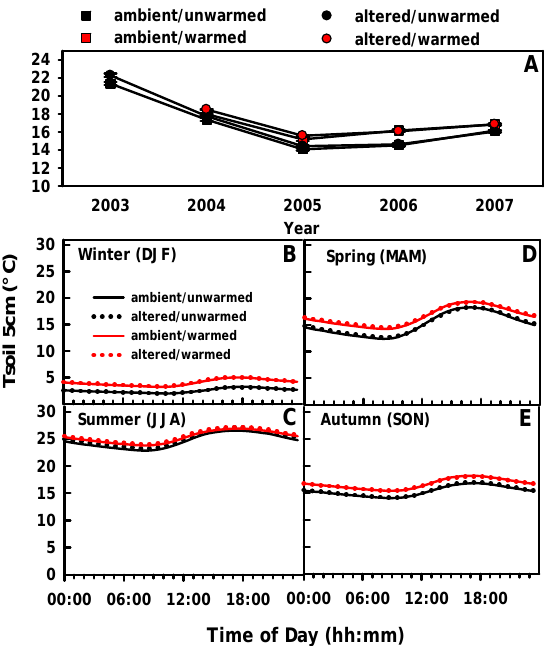
Fig. 3. Soil temperature at 5cm depth ( T soil ) by rainfall pat- 05 tern and warming treatment during 2003–2007. (A) Mean annual soil temperature, error bars denote 1SE. (B–E) Diurnal variation in T soil for each 05